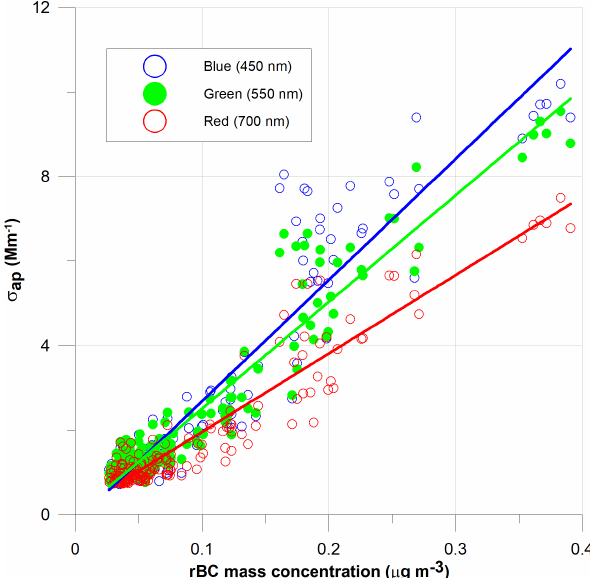
Figure 2. Particle light absorption coefficient ( σ ap ) at three wave- lengths (450, 550 and 700nm) plotted against the refractory black carbon (rBC) mass concentrations for all above-detection-limit data collected during Polar 6 flights from Alert, Nunavut, Eureka, Nunavut, and Inuvik, Northwest Territories (NWT). Regression lines are shown for